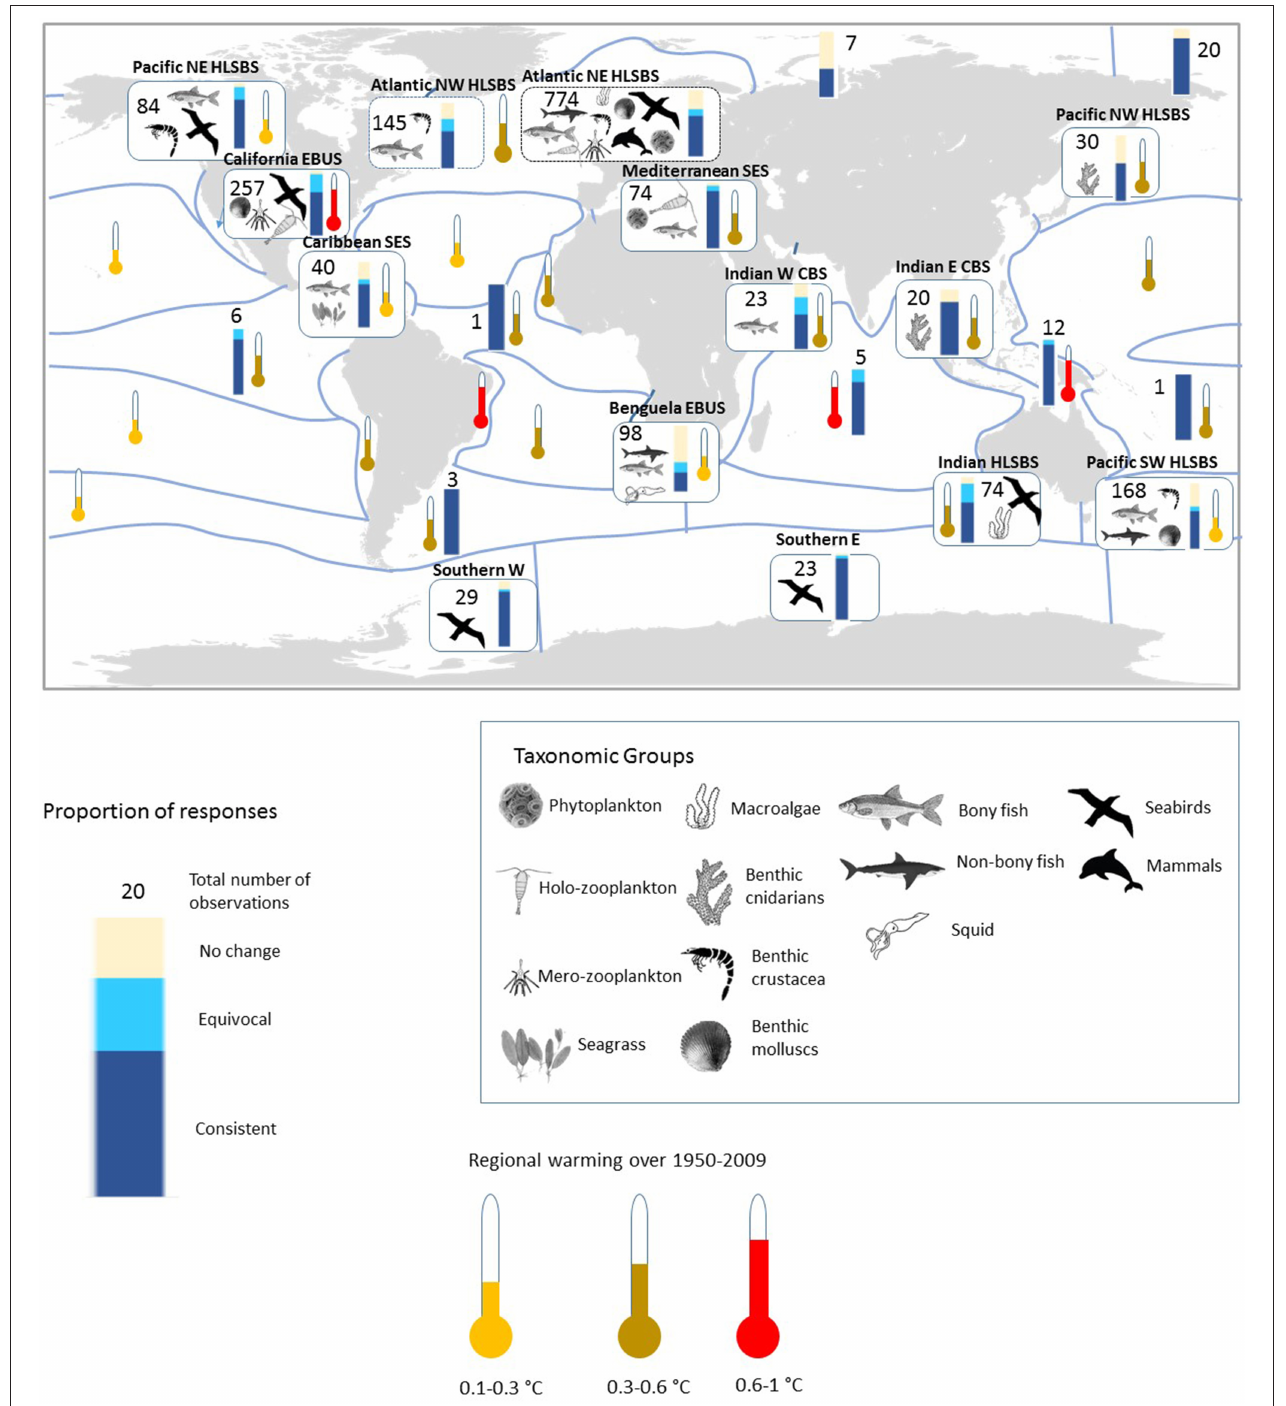
FIGURE 1 | Global distribution of marine ecological impacts across ocean regions. Distribution of climate change responses (including equivocal and no responses) in the abundance, distribution, phenology, demography, and calcification of marine species from the marine climate-change impacts meta-database of Poloczanska et al. (2013) updated with recent literature. The proportion of consistent (dark blue), equivocal (light blue), and no change (pale yellow) observations shown for each region. Numbers are total numbers of observed responses in each region—no number means no regional observations. Taxonomic groups with 10 or more observations in each region are indicated with symbols. Descriptions of taxonomic groups and criteria for selection of observations are given in Poloczanska et al. (2013). Regional temperature increase (all months) over 1950–2009 is shown in three categories: low (yellow 0.1–0.3 ◦ C), medium (orange 0.3–0.6 ◦ C), and high (red 0.6–1.0 ◦ C). The ocean separated into regions based on ecosystem structure and productivity, as well as key oceanographic features. HLSBS, high latitude spring bloom system; EBUS, eastern boundary upwelling system; SES, semi-enclosed sea; CBS, coastal boundary system. A full description of ocean regionalization and the calculation of regional warming increases are given in Hoegh-Guldberg et al. (2014) (Figure 30-1 and Table 30-1) and (Hoegh-Guldberg et al., 2014).